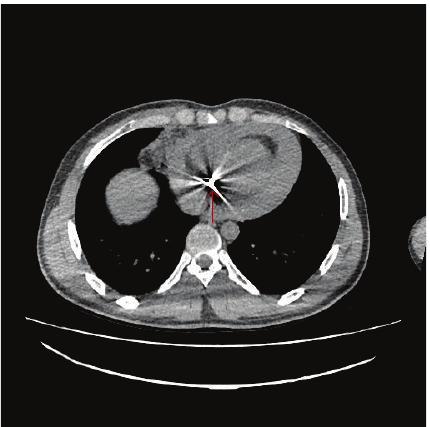
Figure 1: Transverse cut view of chest CT shows a bullet in the left shoulder at proximal humerus.